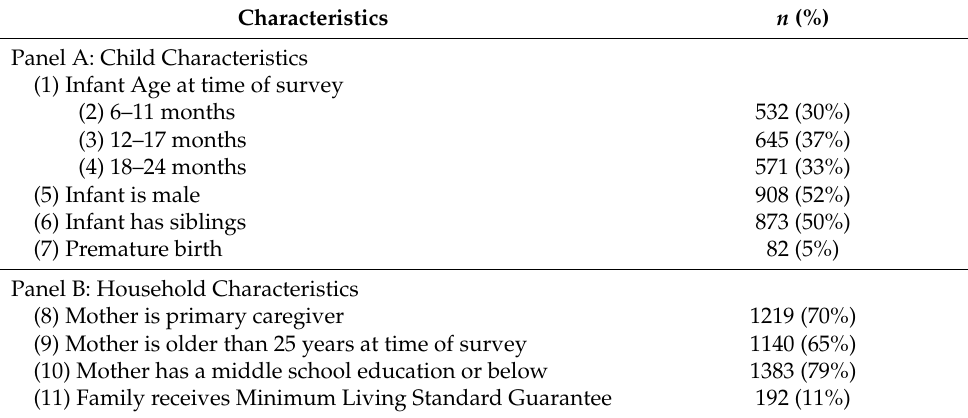
Table 1. Basic characteristics of children and caregivers ( n =